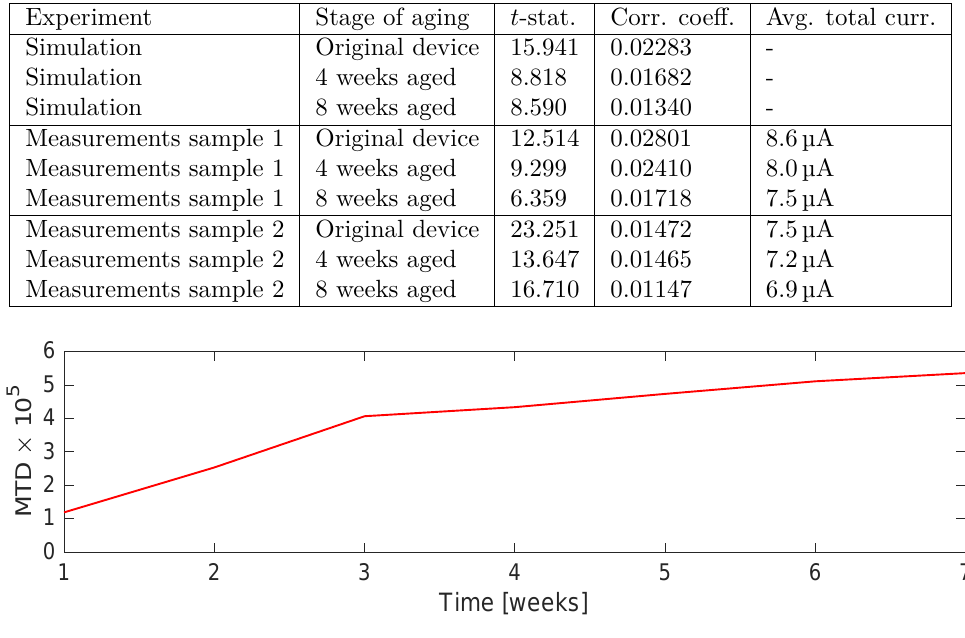
Figure 12: 150 nm ASIC chip, 90 ◦ C, 10 % over voltage, average number of measurements to disclosure (MTD) for a successful key recovery over 7 consecutive weeks under aging